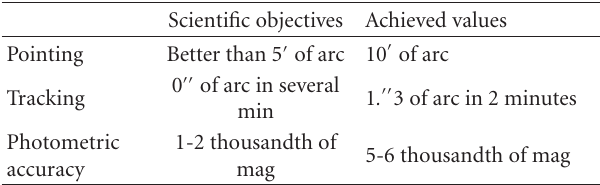
Table 1: Values of pointing, tracking and photometric accuracy necessary for our scientific objectives and those achieved in the T35